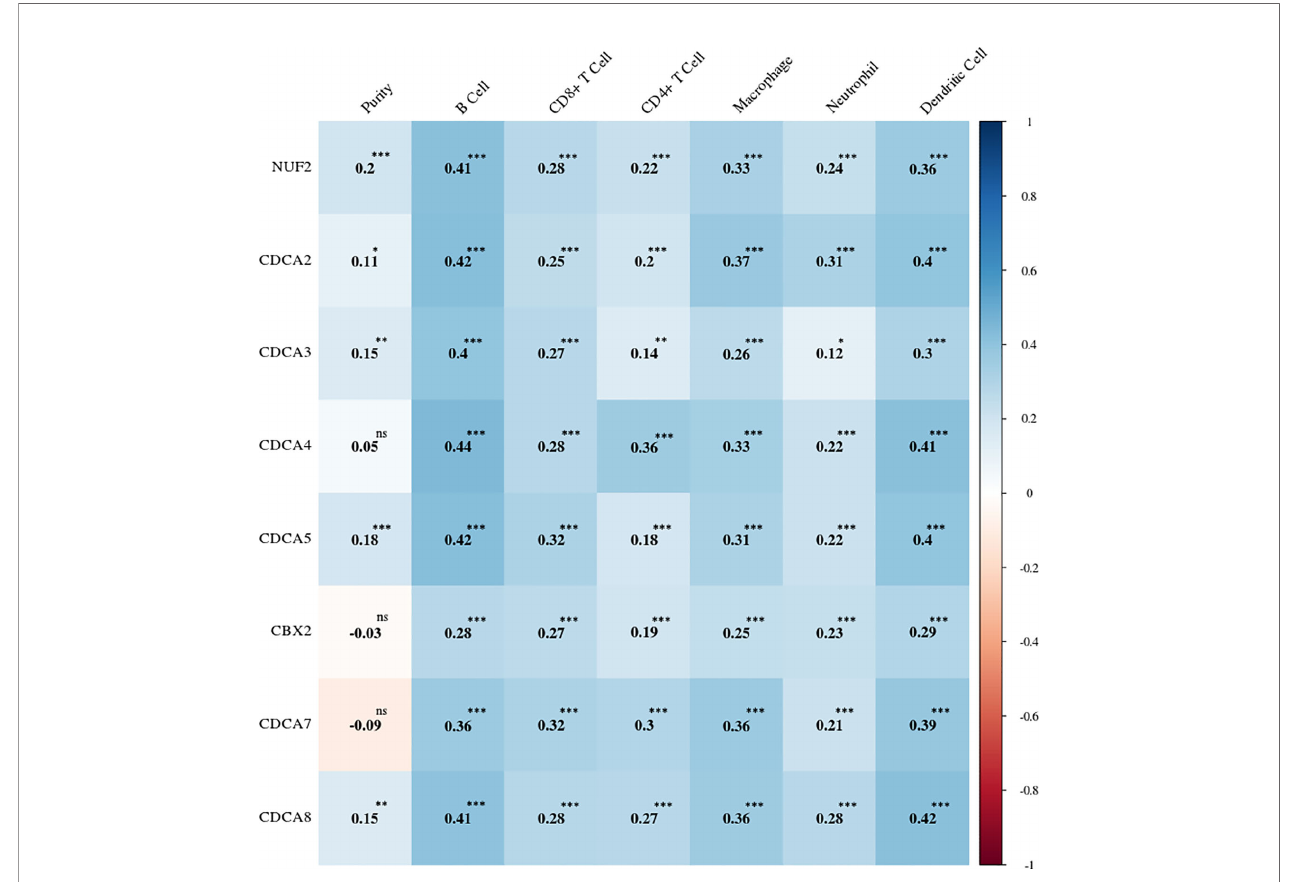
FIGURE 8 | Correlation heatmap between the expression levels of CDCAs and the immune in fi ltration levels. The number shows the correlation value. ns, no statistical signi fi cance; *p < 0.05; **p < 0.01; ***p <